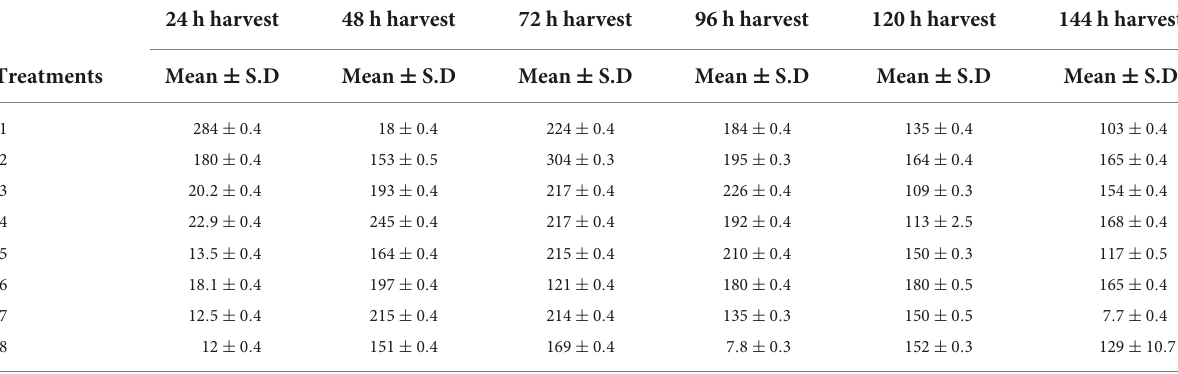
TABLE 2 Flavonoid content ( µ g g − 1 ) of Silybum marianum exposed to different treatments of